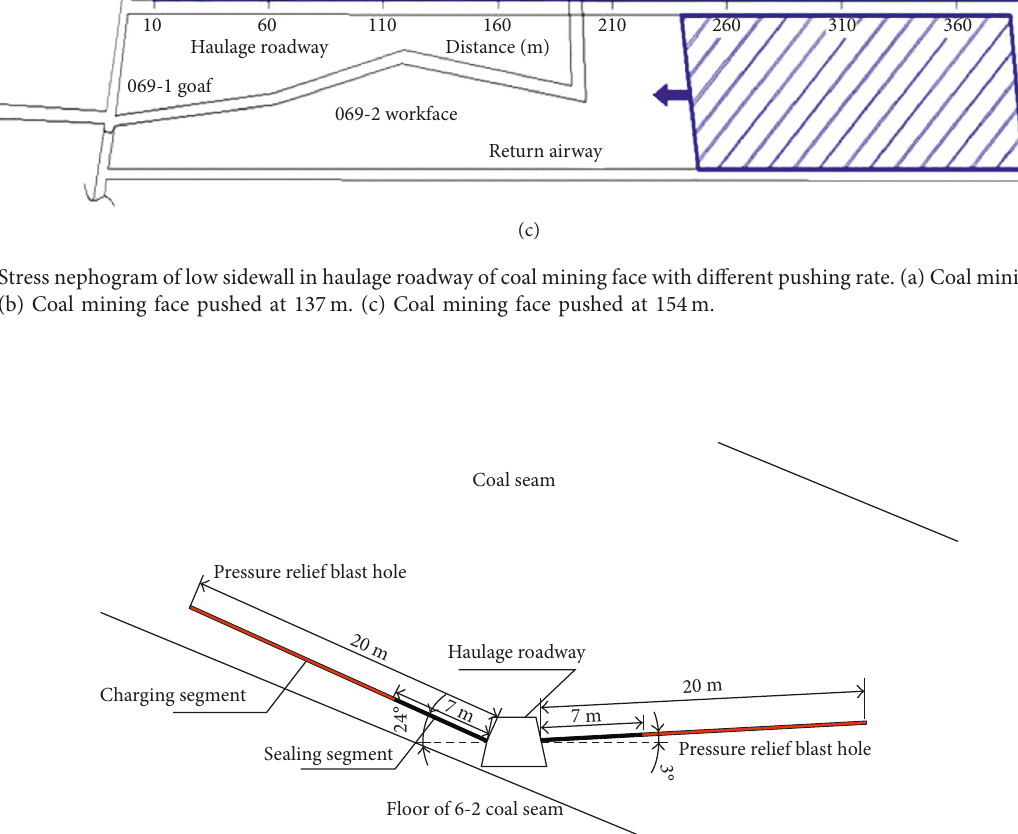
Figure 10: Engineering diagram of seam blasting and pressure releasing in gateway of no. 069-2 coal mining